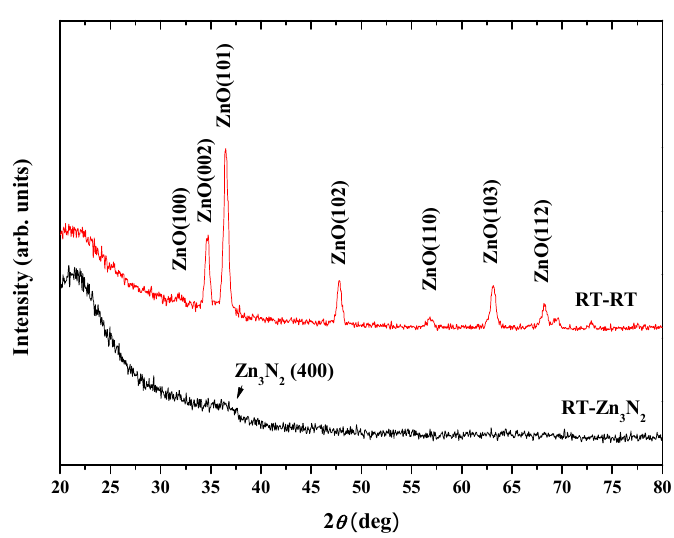
Figure 6. XRD patterns of Zn 3 N 2 film grown at room temperature (labelled as RT-Zn 3 N 2 ), and the ZnO:N film prepared by oxidizing RT-Zn 3 N 2 at room temperature in the oxygen plasma atmosphere (labelled as RT-RT).